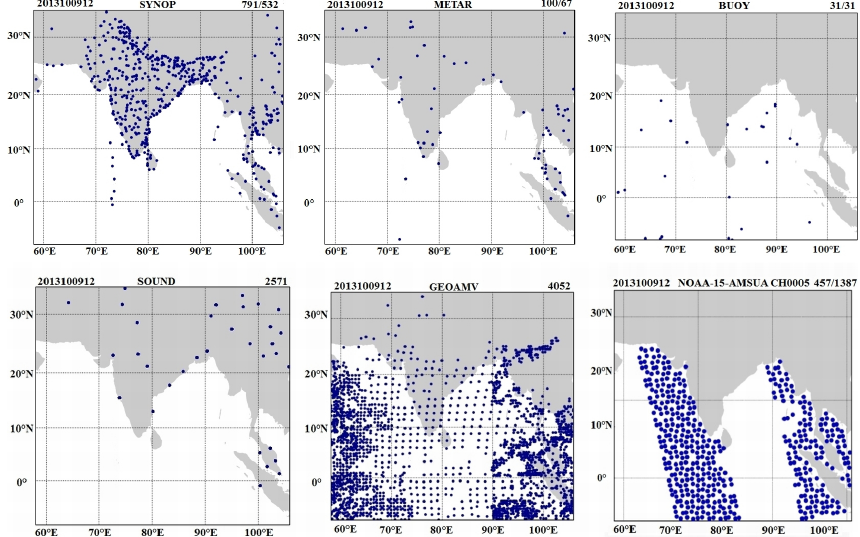
Figure 2. Spatial distribution of different observations used in assimilation experiment VARPREP + RAD for Phailin at 12:00UTC 9 October